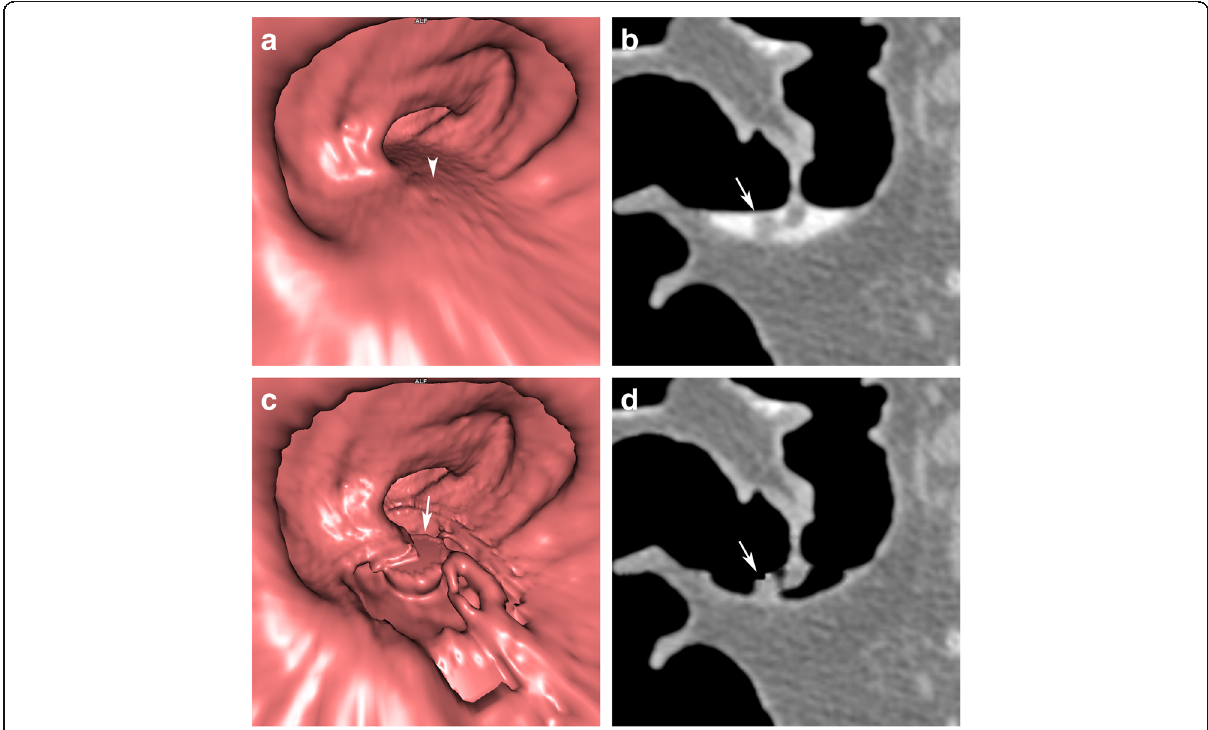
Fig. 9 Changes in the morphologic appearance of a pedunculated colonic polyp in the sigmoid colon due to EC. a On endoluminal 3D views, a horizontal fluid layer in the descending colon obscures a pedunculated polyp before EC (arrowhead). b On the axial 2D image before EC, the soft tissue lesion is almost completely submerged in hyperdense tagged residues (arrow). c After EC, the polyp head presents with an irregular shape, with a reduced conspicuity on endoluminal 3D views (arrow). d Axial 2D image after EC, showing the soft tissue lesion associated with some linear artefacts (arrow). Note that unsubtracted 2D views are helpful to evaluate this